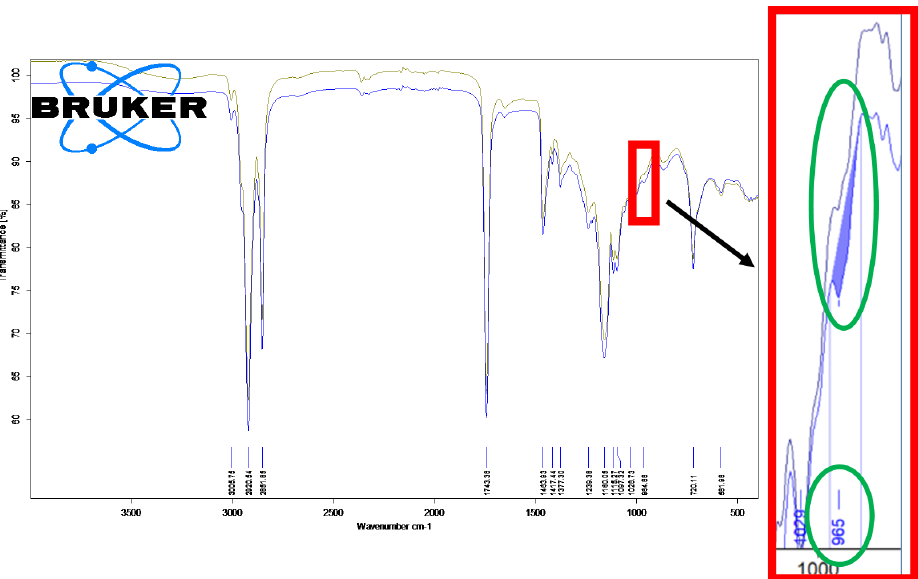
Figure 9. Superimposed Fourier-transform infrared spectroscopy (FTIR) spectra for the raw (unprocessed, green-U1) and thermally processed (blue-P1) Mangalitza lipid fraction (layer 1). The FTIR band at ~965 cm − 1 is assigned for trans fatty acid glycerides and is more intense for the thermally processed sample (see the detail in red).